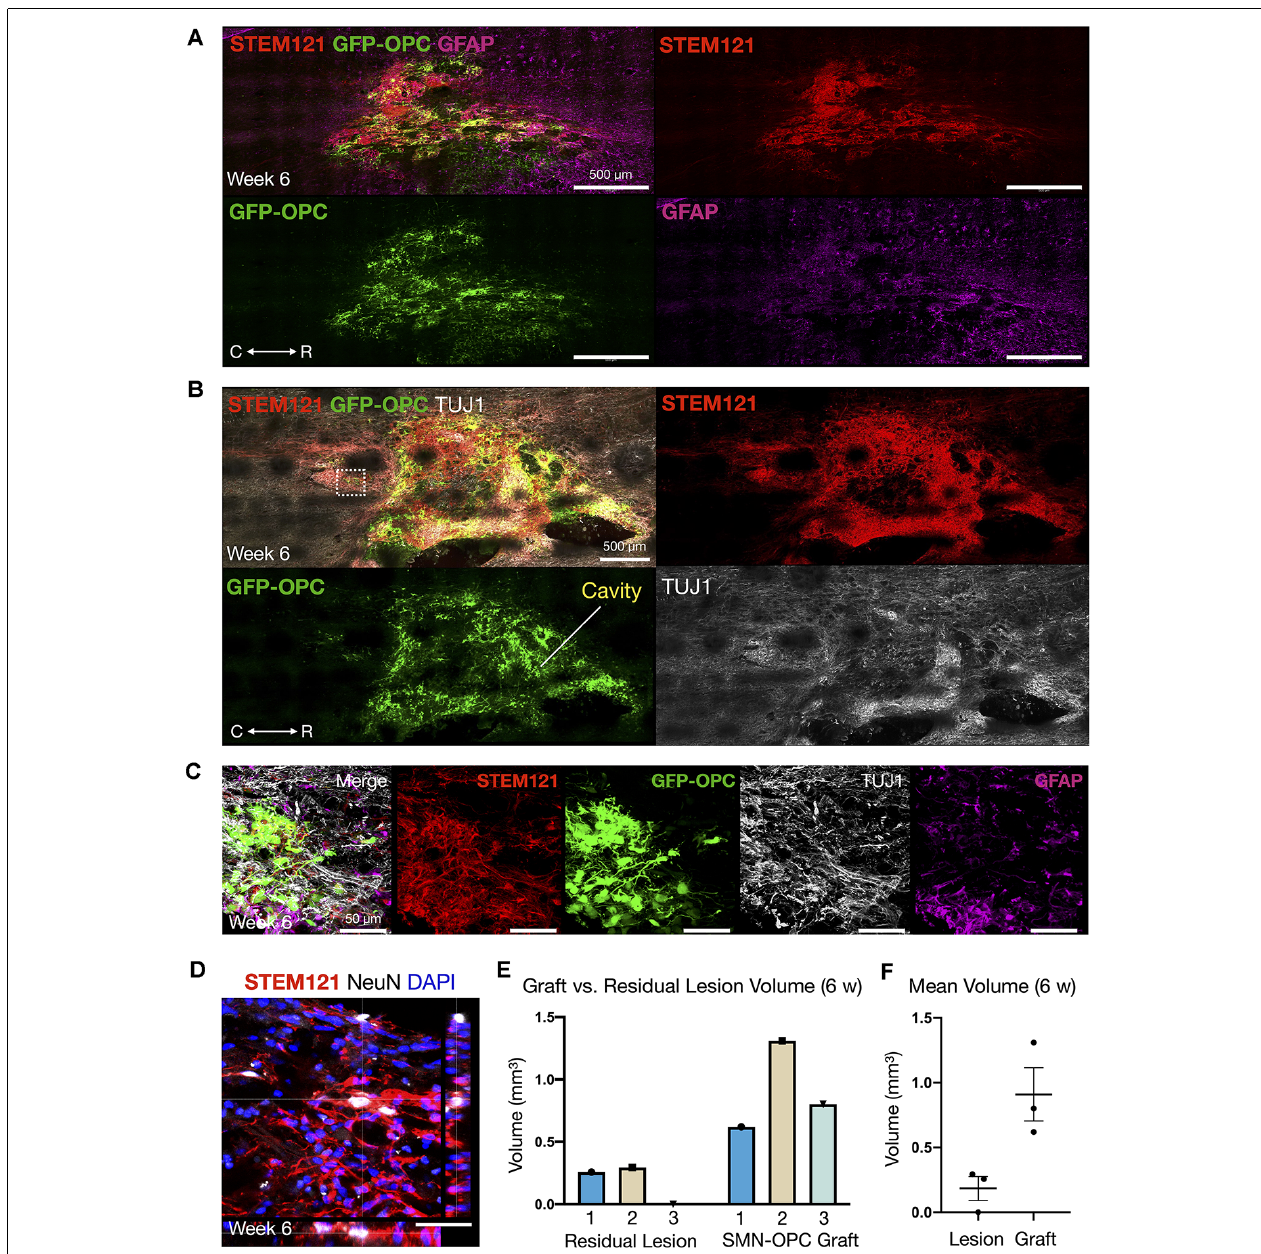
FIGURE 5 | Continued survival of SMN-OPC cell suspensions at 6 weeks post-transplantation. (A) Low power image of the graft at 6 weeks shown with STEM121/GFP-OPC/GFAP to depict host glial cells. (B) Low power image of the graft at 6 weeks shown with STEM121/GFP-OPC and TUJ1 to validate retention of the neuronal phenotype. White box denotes high magnification field shown in (C) , imaged caudal to the lesion epicenter. (C) High magnification merged image and individual channels (STEM121/GFP-OPC/TUJ1/GFAP) at 6 weeks post-transplantation. (D) STEM121 immunostain with mature neuronal marker NeuN co-localization. (E,F) Cavalieri volumetric analysis of the residual lesion and grafts. Color matching corresponds to the same animal. Shown are residual lesion vs. graft volume for individual spinal cords at 6 weeks (mm 3 ) (E) and mean ± s.e.m (F) . N = 3 animals were sacrificed at 6 weeks post-transplantation. R (rostral), C (caudal). Individual scale bars are